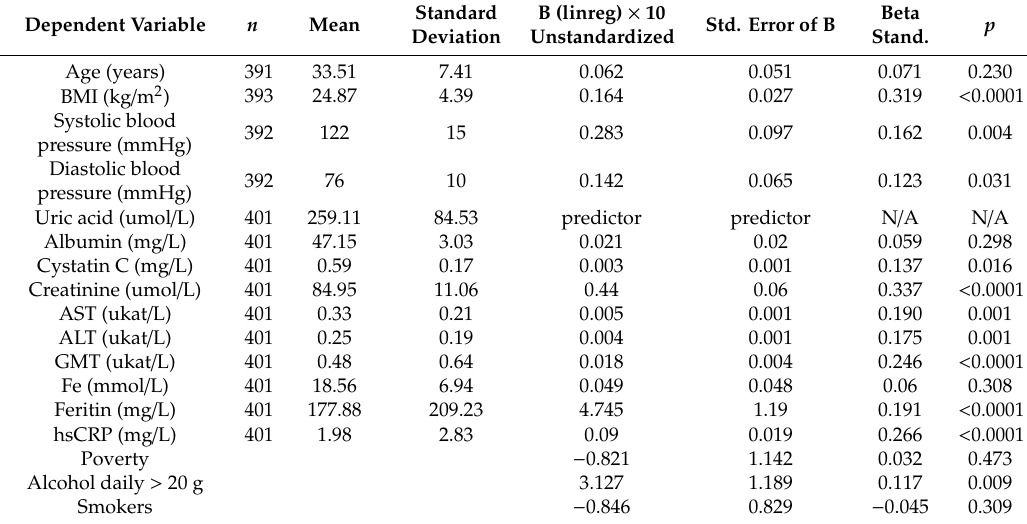
Table 4. Relationship between uric acid adjusted for age and sex and dependent variables in the non-Roma